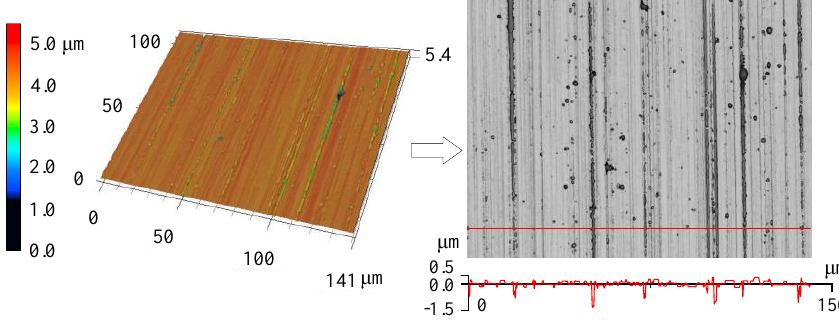
Figure 15. The surface morphology and contour of a formed ChG pillar.